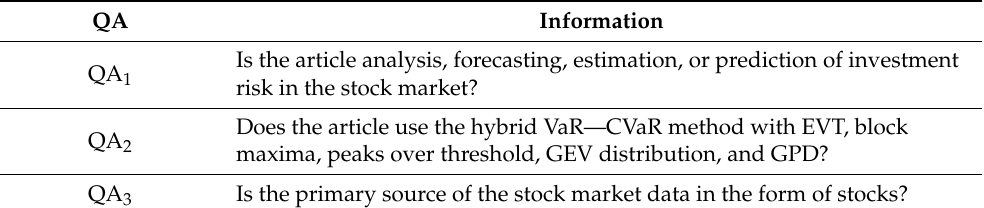
Table 3. Quality assessment criteria.